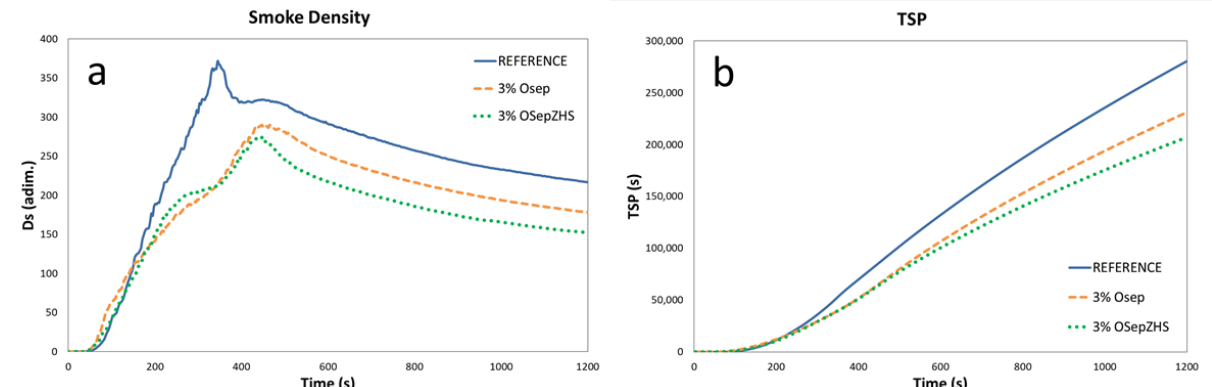
Figure 10. Smoke chamber test results: ( a ) Smoke Density (Ds) and ( b ) Total Smoke production (TSP) curves.